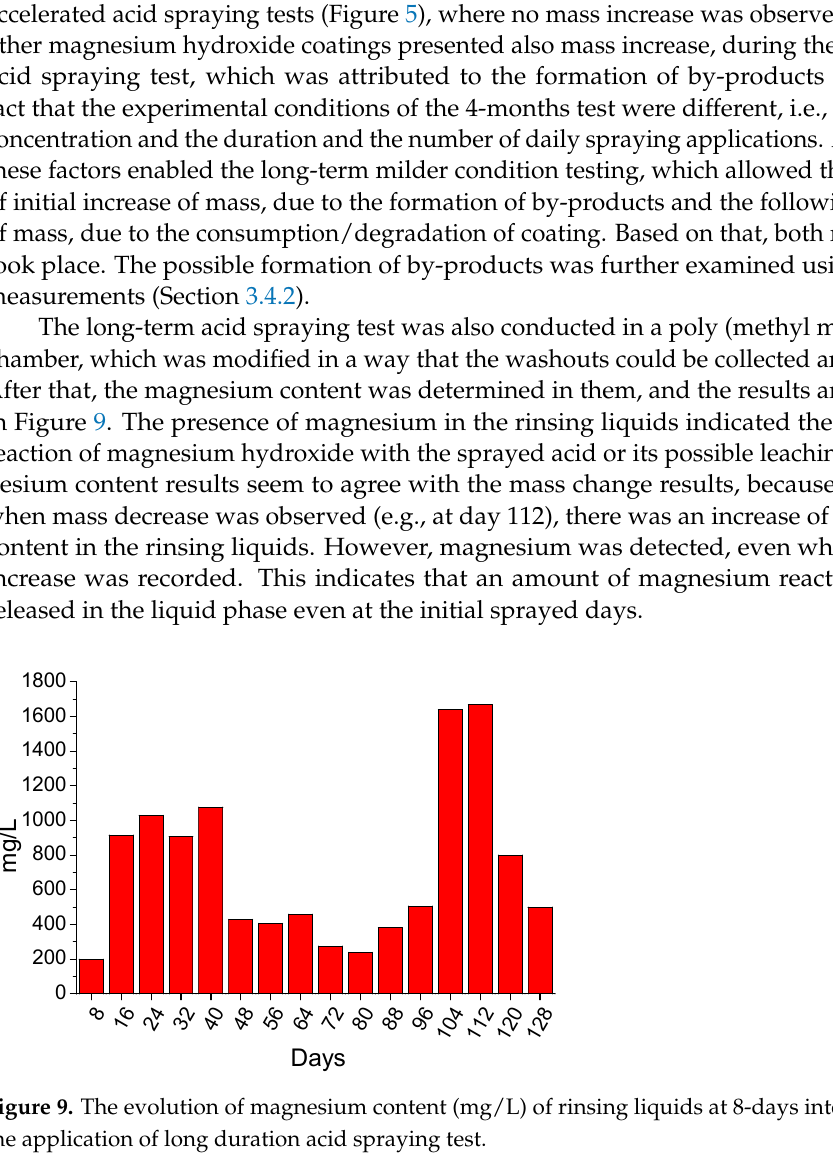
Figure 8. The evolution of mass changes of coated concrete specimens during the application of long-term duration acid spraying test.